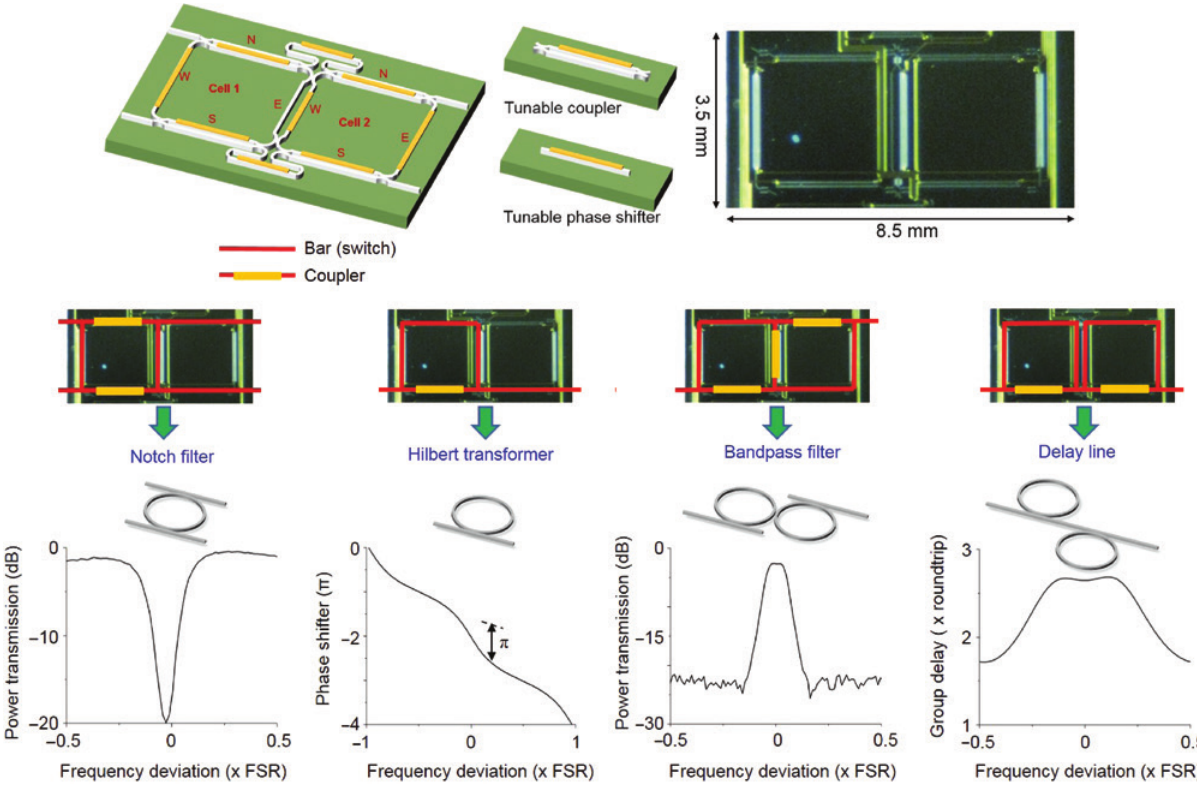
Figure 17: A proof-of-concept device fabricated in TriPleX technology, which comprises two mesh cells, and demonstration of its program- mability [45] (Copyright in 2015, Optical Society of